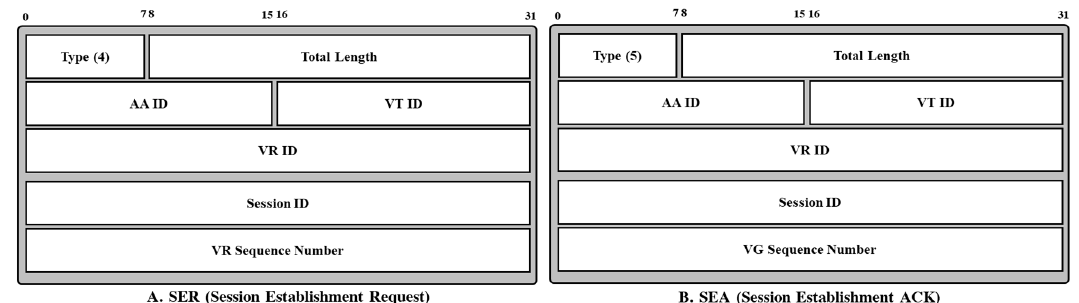
Figure 10. Session Establishment Request (SER) and Session Establishment ACK (SEA) messages.